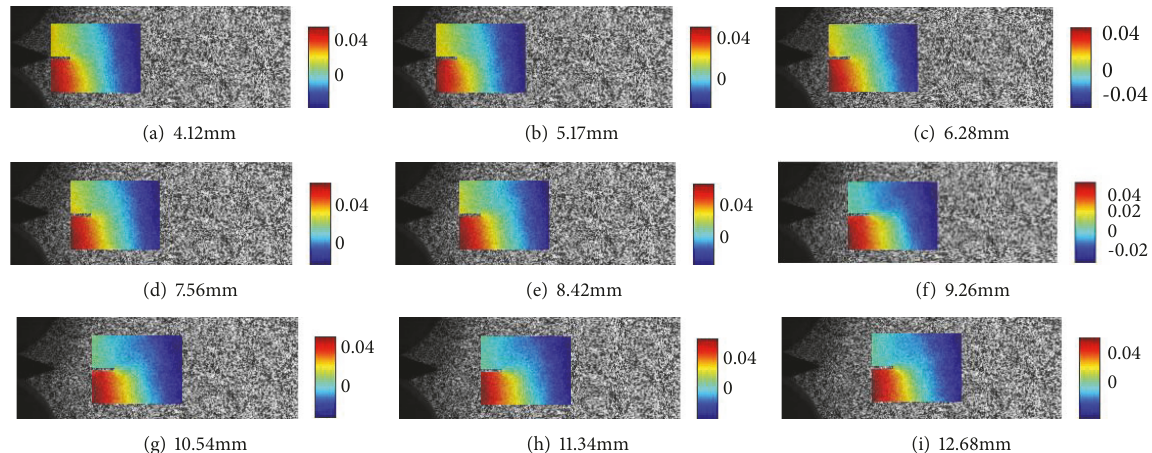
Figure 20: Y-direction displacement amplitude fields of crack tip region with different crack lengths.